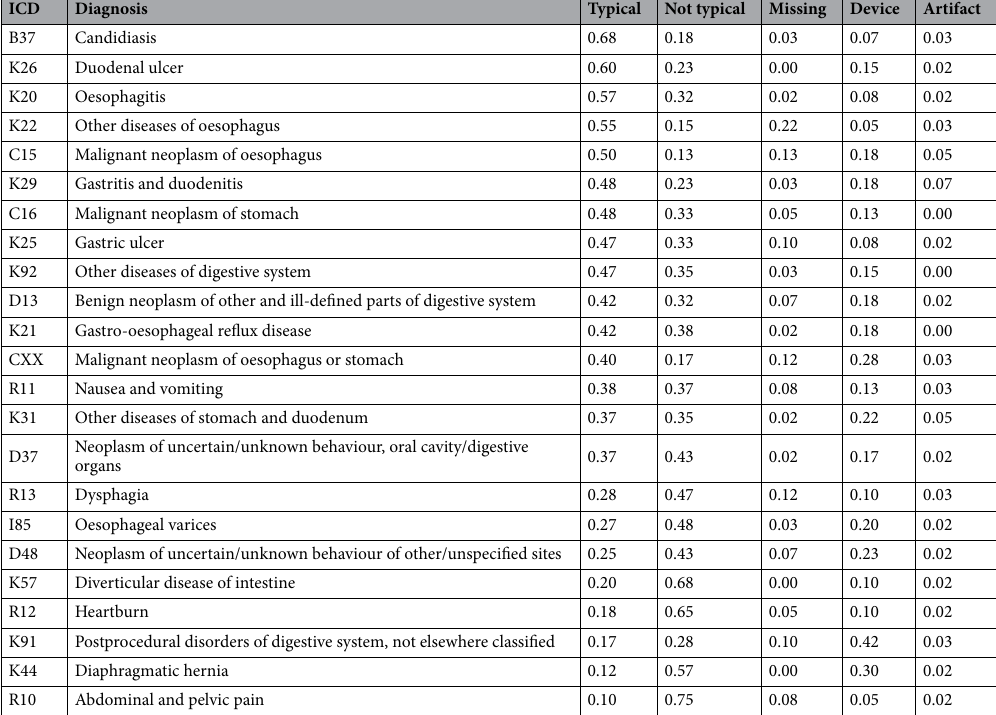
Table 3. Results of the reader study in the gastroscopy data set. For each diagnosis category in the gastroscopy dataset, the AI system selected 60 highly predictive images (2 highest scoring images from 10 highest scoring patients in each of the 3 folds). These images were manually classified into five categories by a trained observer. The fraction of images in each category in every category is